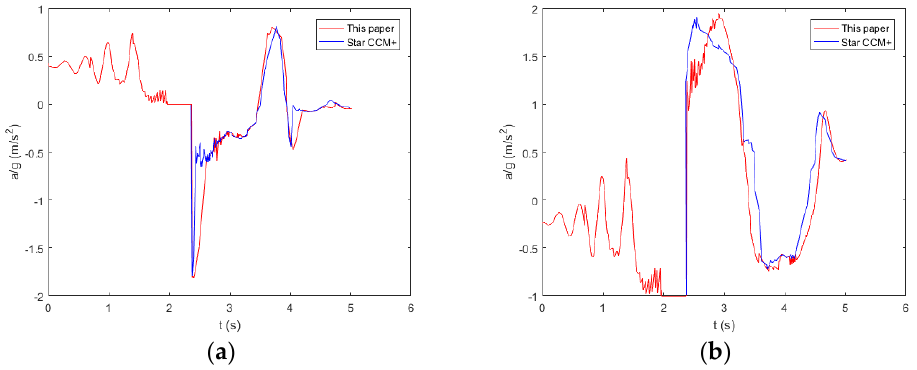
Figure 8. Acceleration of center of gravity of the lifeboat in the horizontal ( a ) and vertical ( b ) direction.